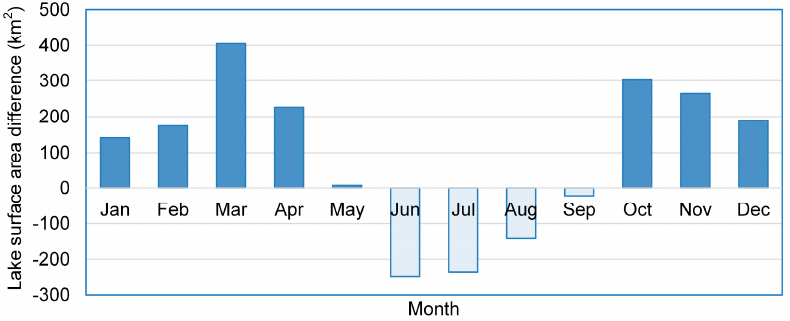
Figure 8. Overall lake surface area di ff erence (MinVC NDVI relative to cloud free NDVI) as a function of month.